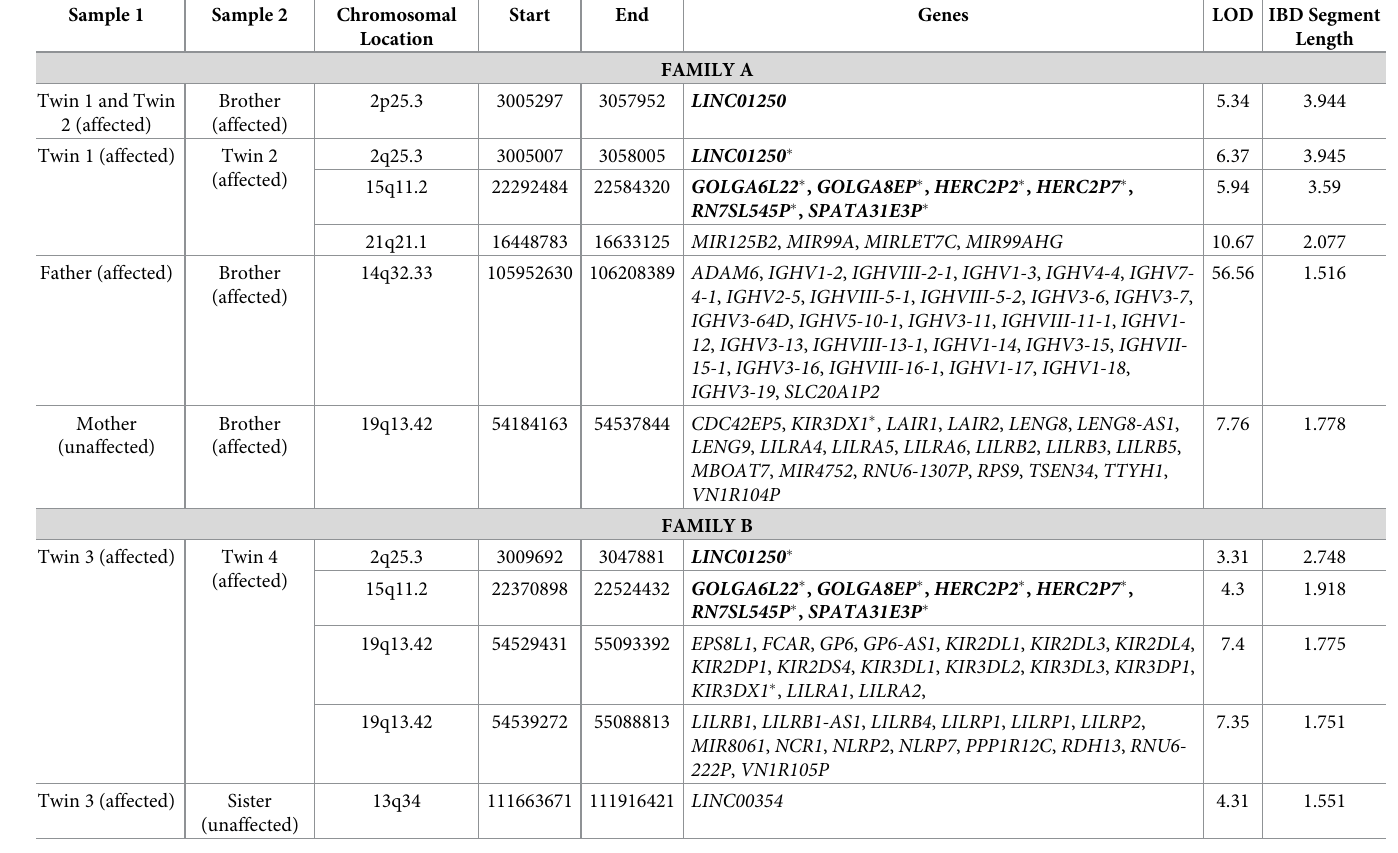
Bold depicts genes common within affected members between families. � depicts genes common within (affected/unaffected) members between